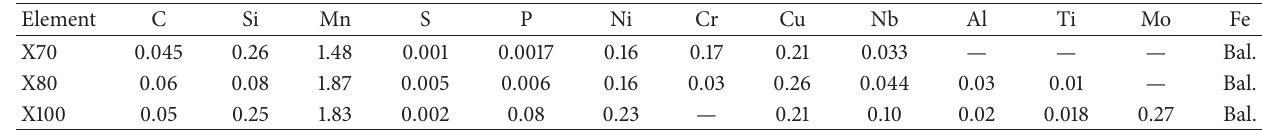
Table 1: The chemical compositions of X70, X80, and X100 pipeline steels (wt. %).